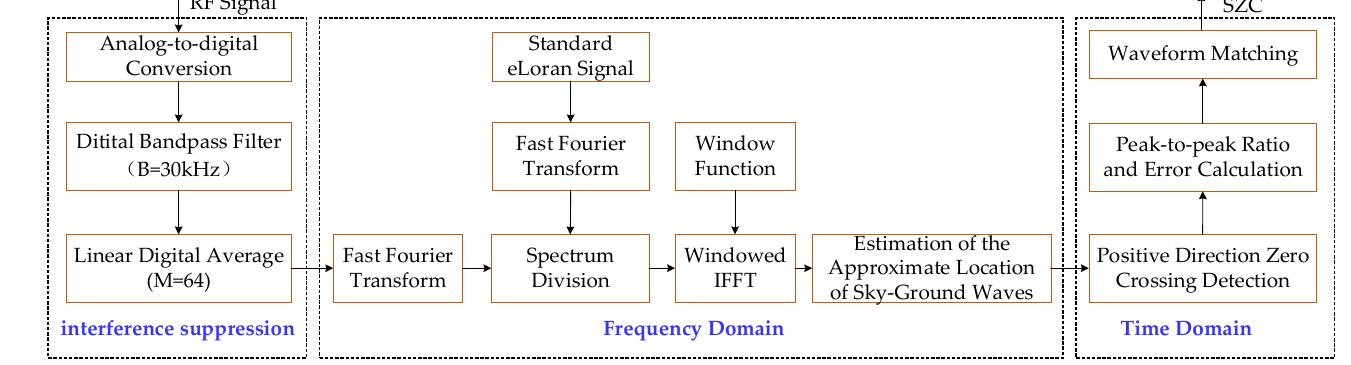
Figure 5. Principle of time–frequency domain joint cycle identification method.